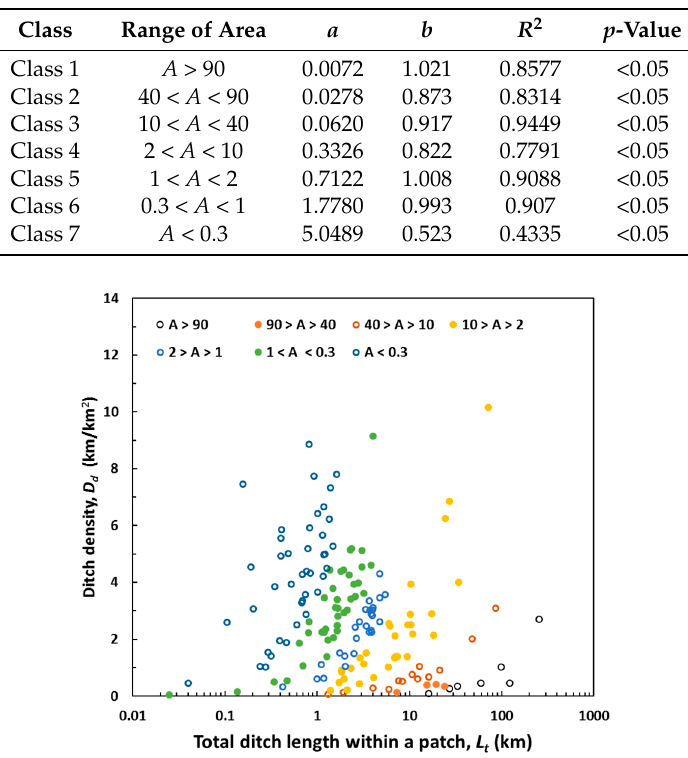
Figure 9. Relationships between ditch density ( D d ) and total ditch length within a peatland patch for all patches ( L t ) that were classified into seven groups based on patch areas ( A ).